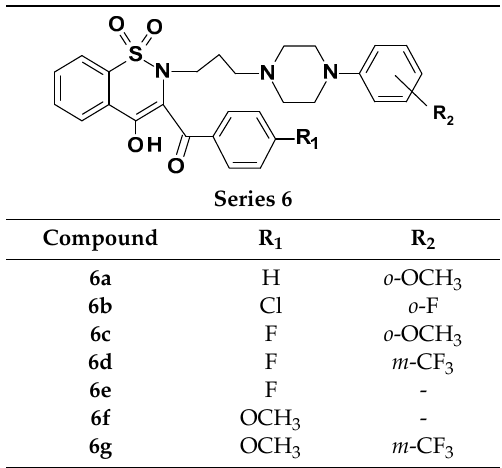
Figure 6. Chemical Structure of Compound 3e . Table 7. Structures of series 6 compounds.